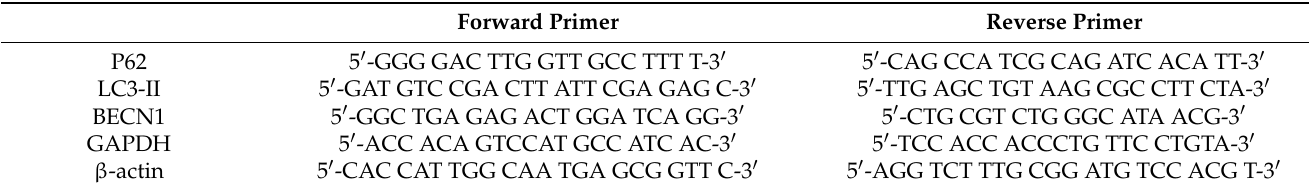
Table 1. Primers used for RT-qPCR.